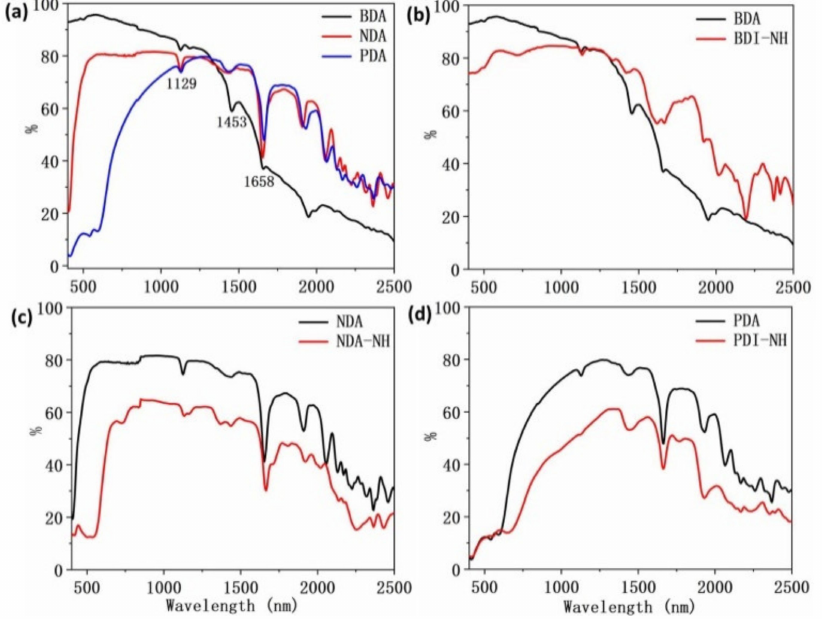
Figure 3. NIR reflectance spectra of: ( a ) BDA, NDA and PDA, ( b ) BDI-, ( c ) NDI-, and ( d ) PDI-based compounds with anhydride and amine